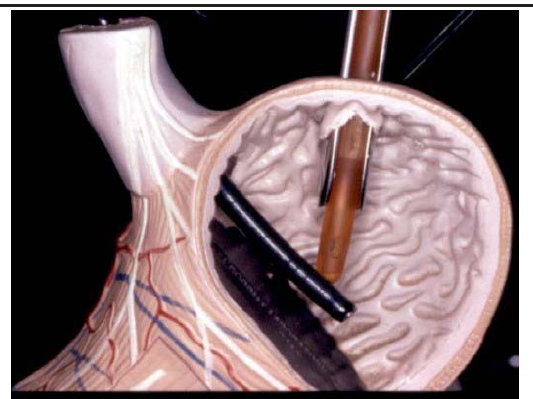
FIGURE 7 - Surgery view of urological trocar been introduced on the skin until the gastric lumem.